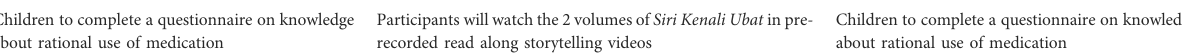
TABLE 1 One group Pre-test-Post-test Design.